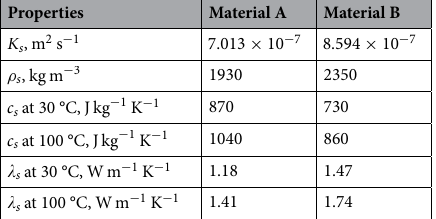
Table 7. Thermal properties of composite materials of brake